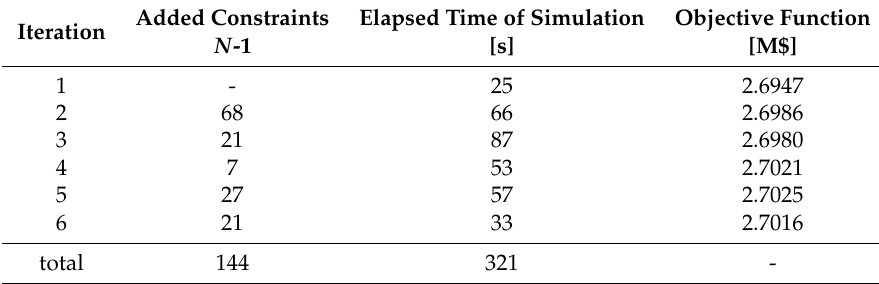
Table 3. Performance of the SCUC formulation (TCF = 0.8 and inGAP =